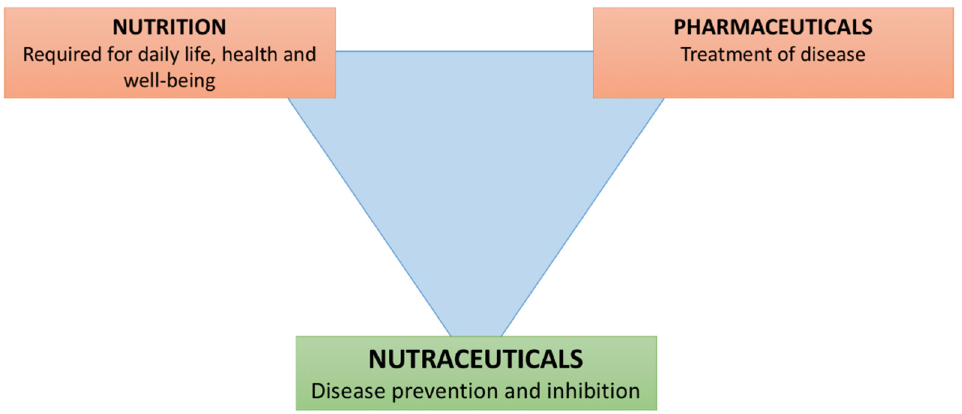
Figure 1. Role of nutraceuticals in health and disease.